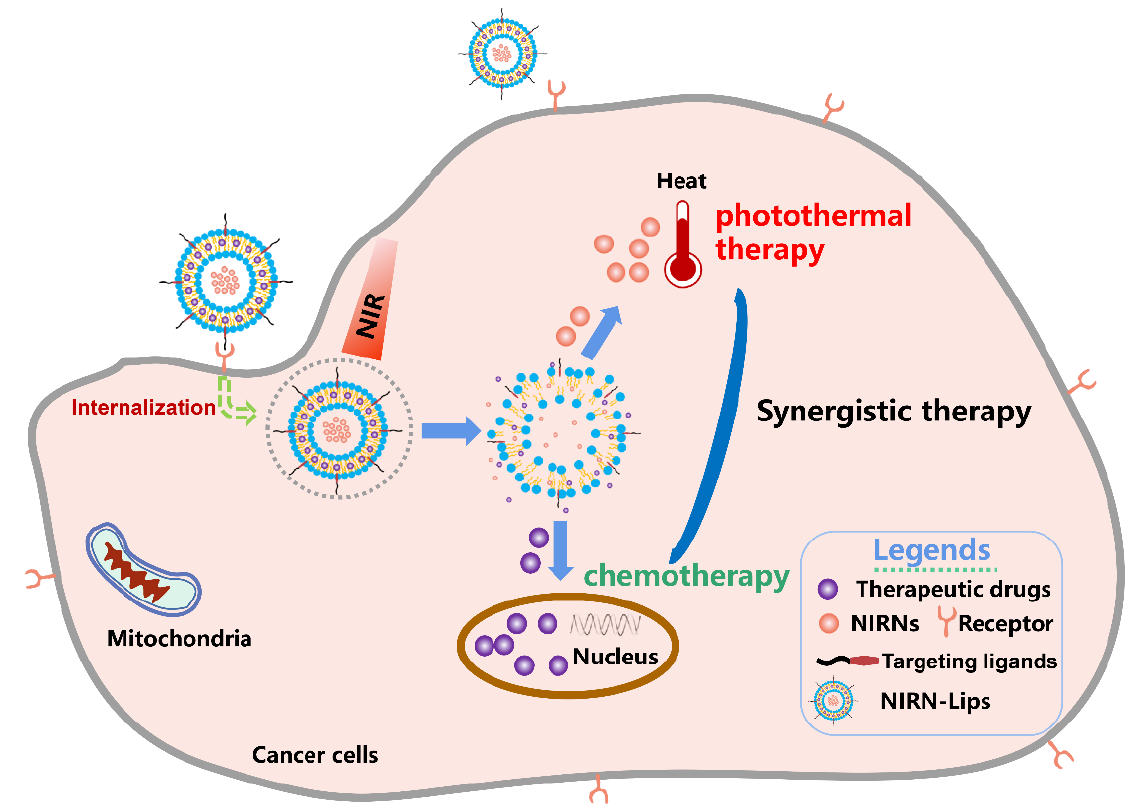
Figure 5. NIR light-triggered drug release mechanism of NIRN-Lips.